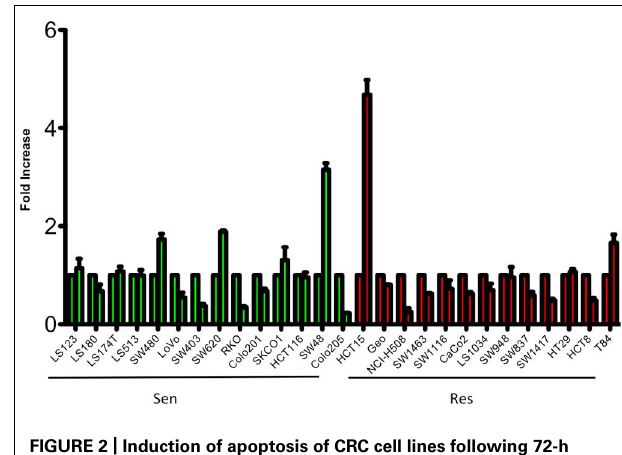
FIGURE 2 | Induction of apoptosis of CRC cell lines following 72-h treatment with PF-3758309 at concentration 1.0 μ mol/L.